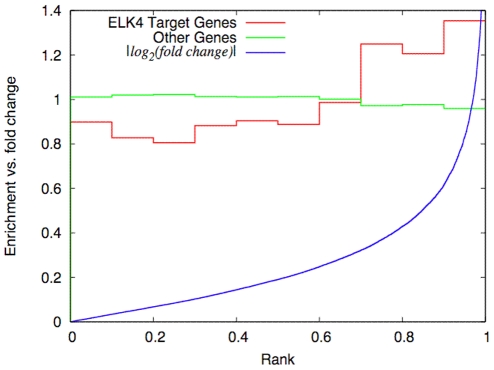
Rank distributions of the 1826 putative ELK4 targets (red) vs. the 16101 remaining genes (green).The ranks are derived from the list of target genes sorted according to their fold changes (blue) in the miR-155 transfection experiment at 32 h. The distributions are normalized to show the relative overrepresentation of ELK4 targets in histogram bins of |log2(fold change)| >0.4 (corresponding to fold changes >1.3, or <0.75) ELK4 targets are enriched by about 50% compared to |log2(fold change)| <0.4. ELK4 is thus identified as an active regulator with a p–value of 2.87E-11 according to the Benjamini-Hochberg corrected the Wilcoxon test.